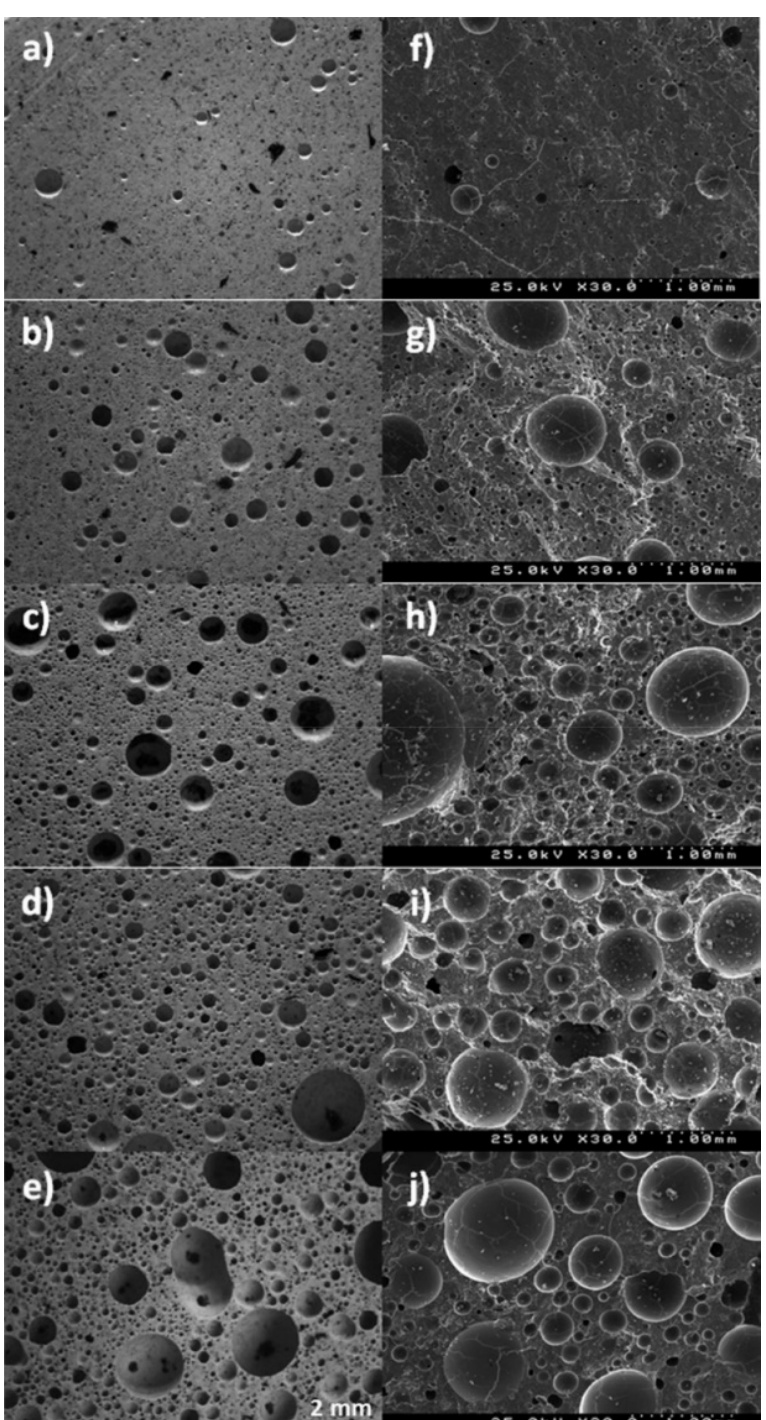
Figure 6. Optical microscopy and SEM characterization of fly ash geopolymers produced with di ff erent amounts of H 2 O 2 as foaming agent (( a ) and ( f ) 0.03 wt. %, ( b ) and ( g ) 0.15 wt. %, ( c ) and ( h ) 0.30 wt. %, ( d ) and ( i ) 0.90 wt. % and ( e ) and ( j ) 1.20 wt. %). Reprinted from Reference [42], © 2020, with permission from Elsevier.